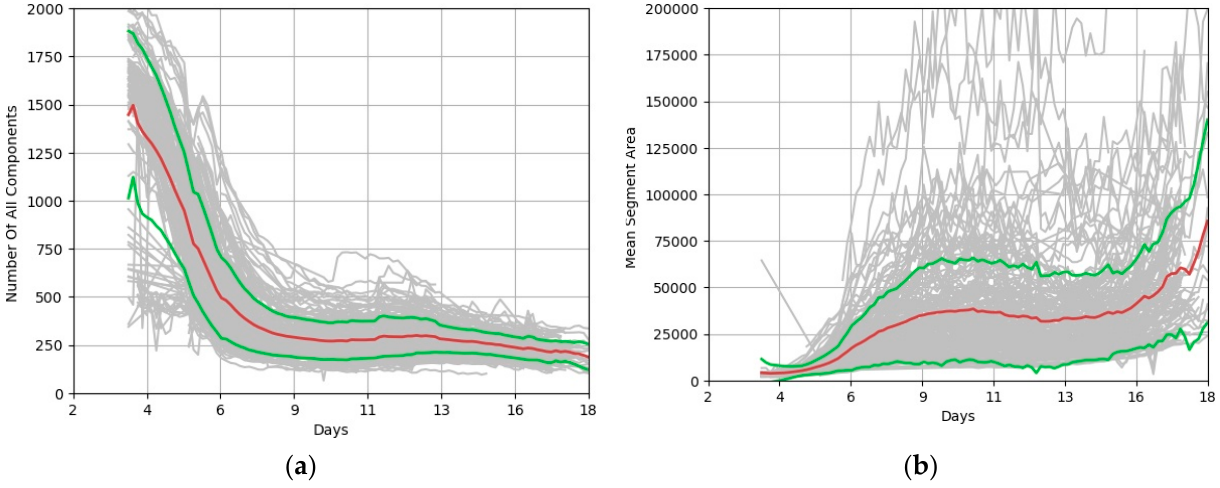
Figure A2. Results of morphological analysis: total number of components ( a ), mean area of com- ponents in pixels ( b ). The brown line represents the medium value, the green line represents stand- ard deviation.